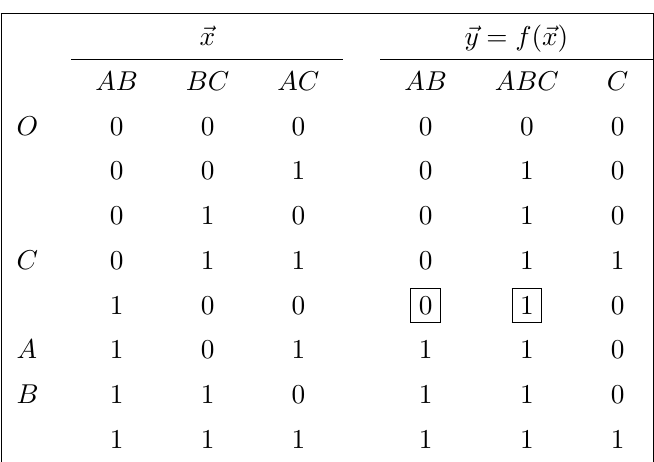
Table 3 . A non-trivial contraction map for a linear combination of strong subadditivity and S ( AB ) (cid:21) S ( AB ), inequality (5.1). The AB column in the image of f ( ~x ) di(cid:11)ers from the AB column on the domain side of f in the boxed entry. The ABC -column of f ( ~x ) di(cid:11)ers from the ABC -column in table 1 (the strong subadditivity contraction map) in the boxed